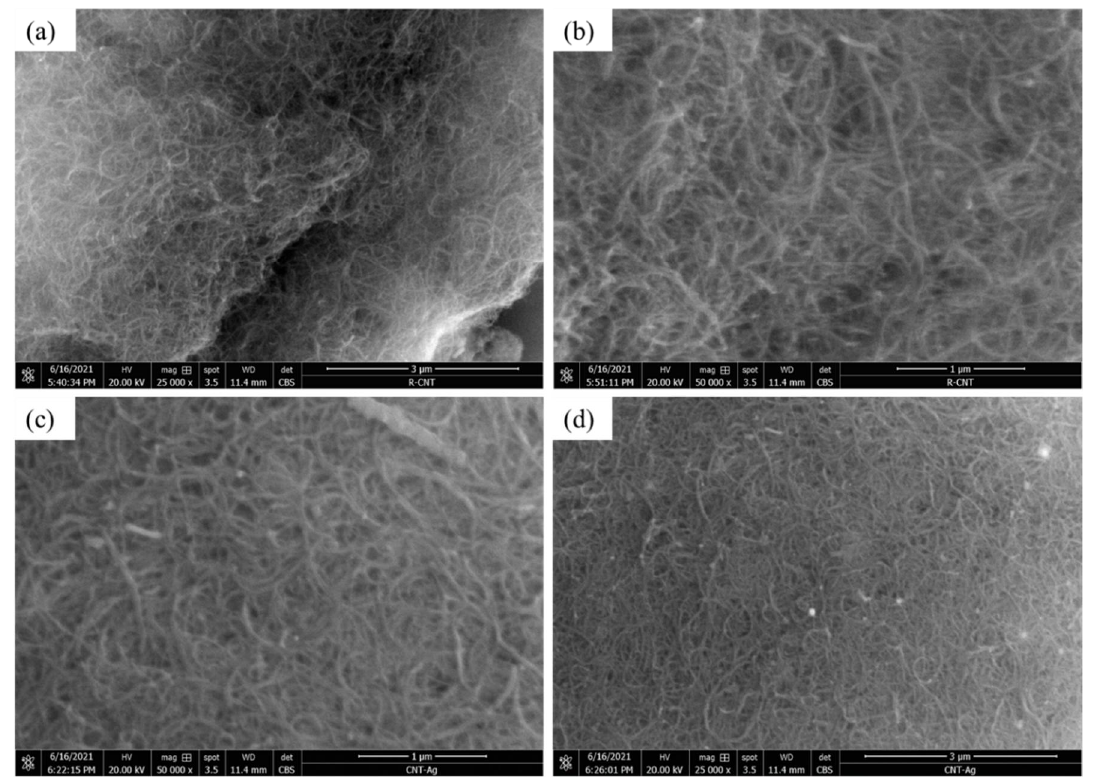
Figure 6. FESEM images of ( a ) raw MWCNTs at low magnification exhibiting a clot-like appearance; ( b ) high-magnification image of raw MWCNTs; ( c ) high-magnification image of MWCNTs-Ag showing effective sonication; ( d ) low-magnification image of MWCNTs-Ag.